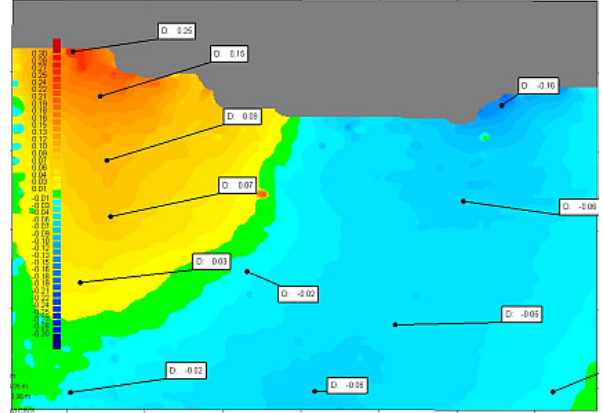
Figure 6: Deviations between the meshed northern façade in comparison to a vertical wall